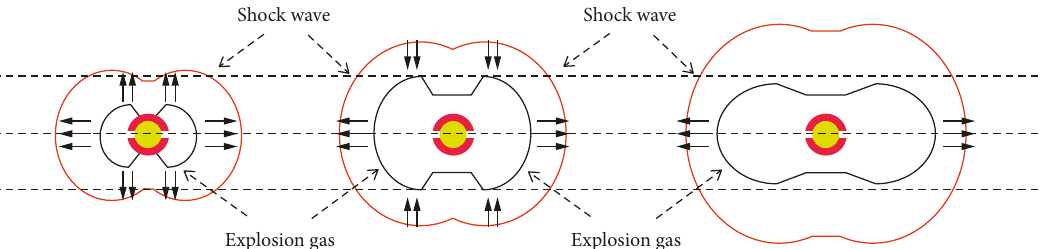
Figure 7: Physical model of explosive gas in cutting seam